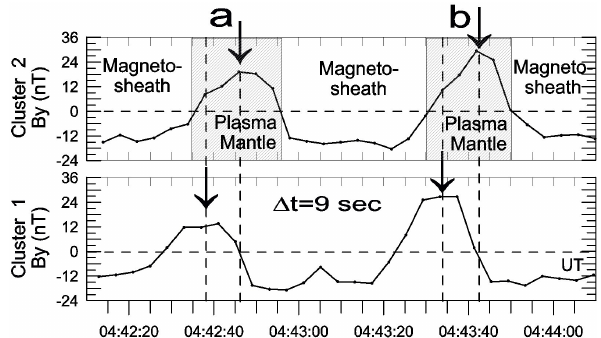
Fig. 6. Two brief entries of Cluster 1 and 2 into the plasma mantle proper (shaded regions with positive B y values). The two satellites separated along the X-axis diagnose a shift in arrival time of magne- topause boundary which is due to a surface wave travelling tailward with a velocity 210km s − 1